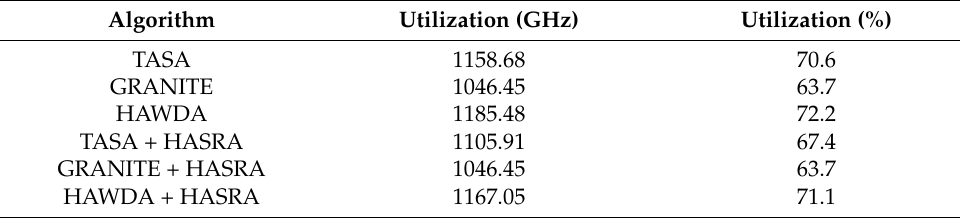
Table 5. Computing capacity